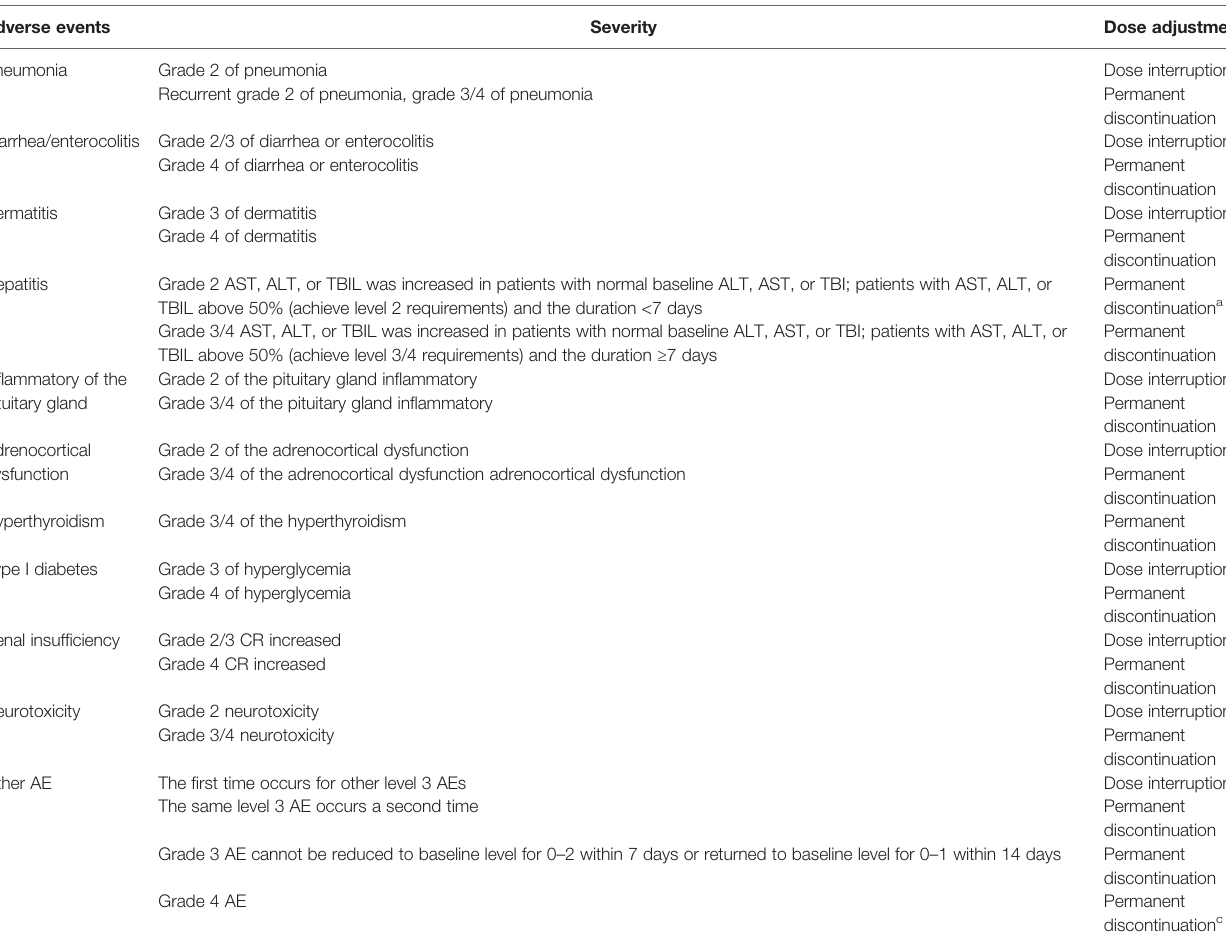
TABLE 2 | Dose adjustment protocol for